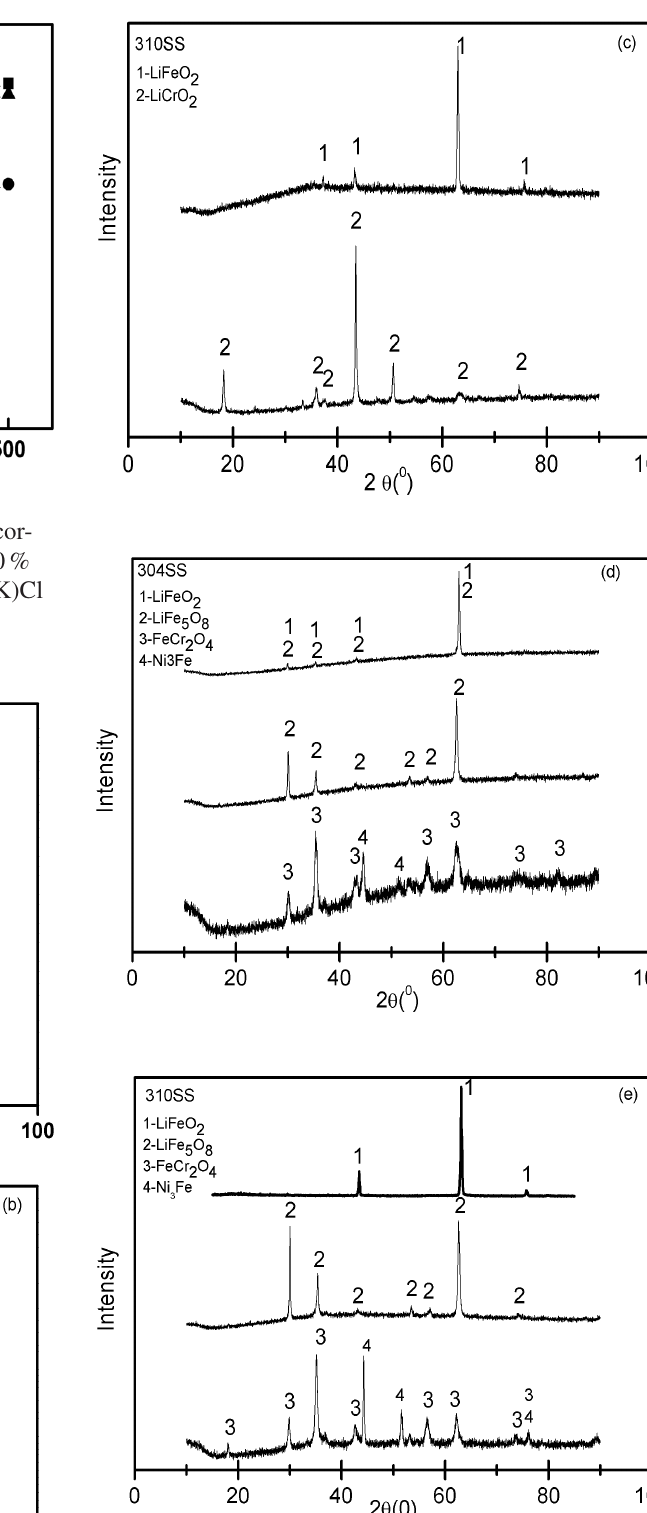
Figure 3. XRD patterns for the corrosion products formed on 304 SS (a), (d), 316 SS (b) and 310 SS (c), (e) cor- roded in (Li,Na,K) 2 CO 3 (a), (b), (c) and (Li,Na,K) 2 CO 3 - (Na,K)Cl (d), (e), respectively, at 973 K for 500